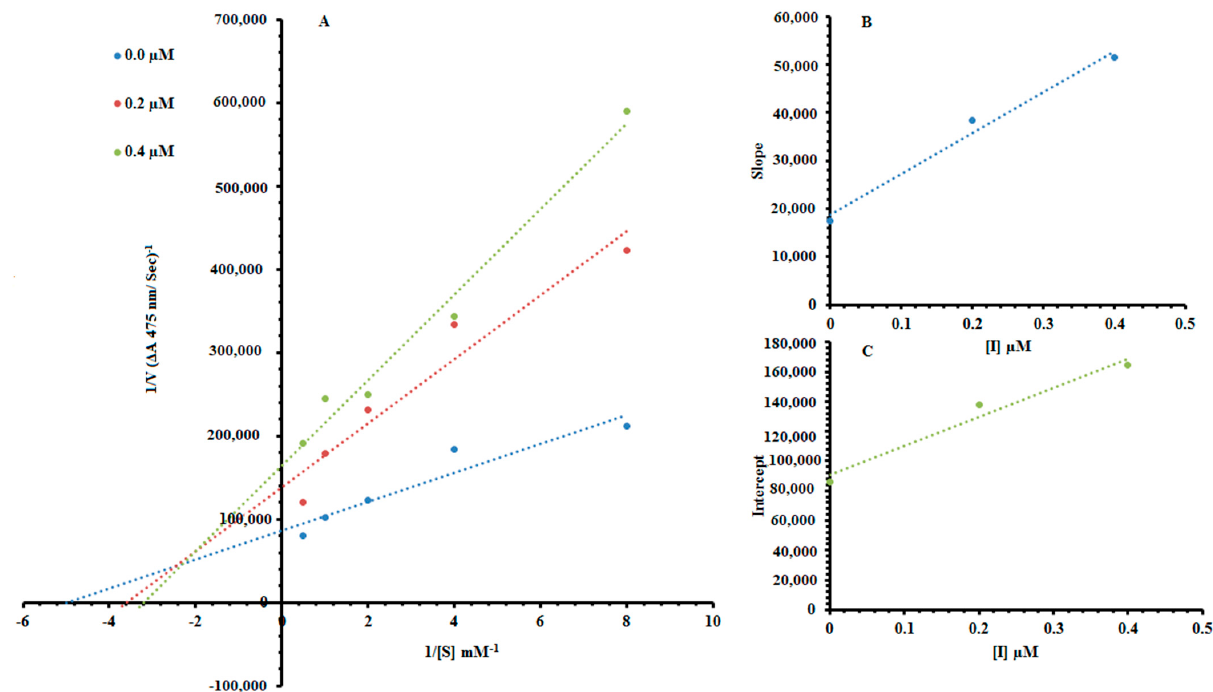
Figure 1. Lineweaver–Burk plots for inhibition of tyrosinase in the presence of 2-((4-methoxyphenethyl)amino)-2-oxoethyl 3,5-dihydroxybenzoate (Ph5). ( A ) Concentrations of Ph5 were 0, 0.2 and 0.4 µ M, respectively. Substrate L -DOPA concentrations were 0.125, 0.25, 0.5, 1 and 2 mM, respectively. ( B ) The insets represent the plot of the slope and ( C ) of the vertical intercepts versus inhibitor Ph5 concentrations to determine inhibition constants. The lines were drawn using linear least-squares fit.